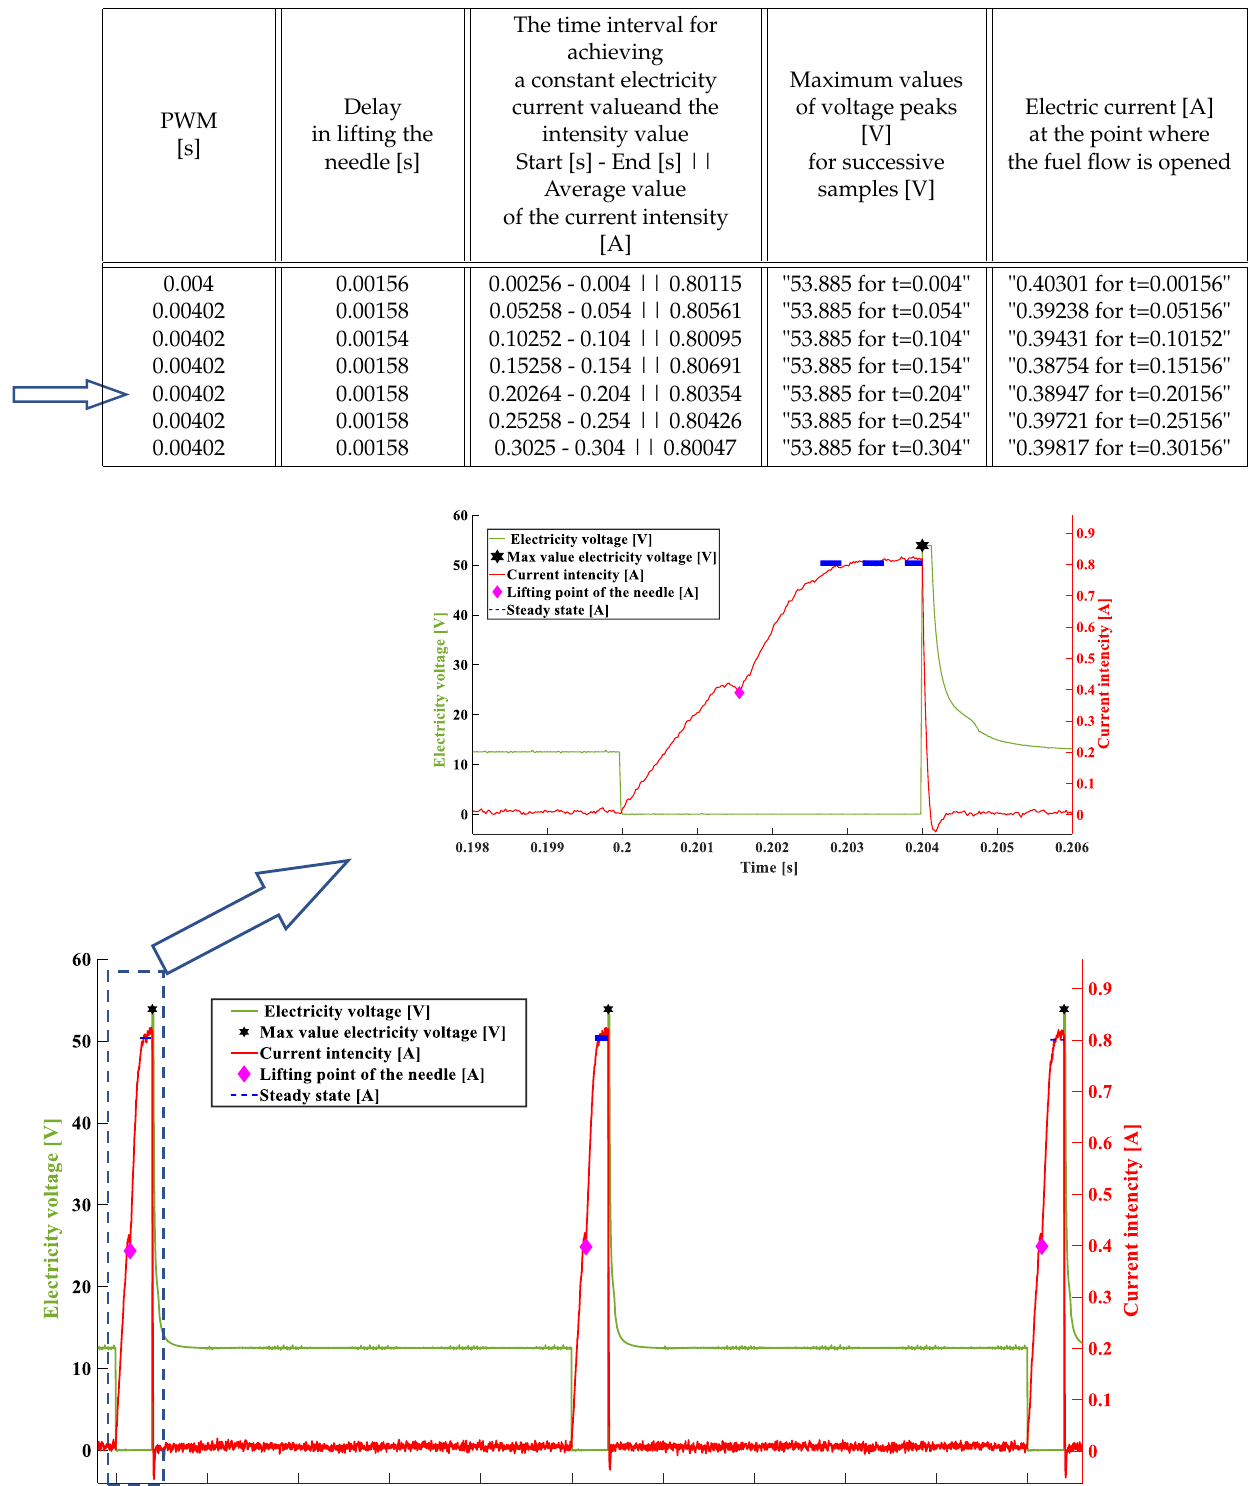
Table 3. User panel filled with selected values—exp. II—4 ms, 0.4 MPa.